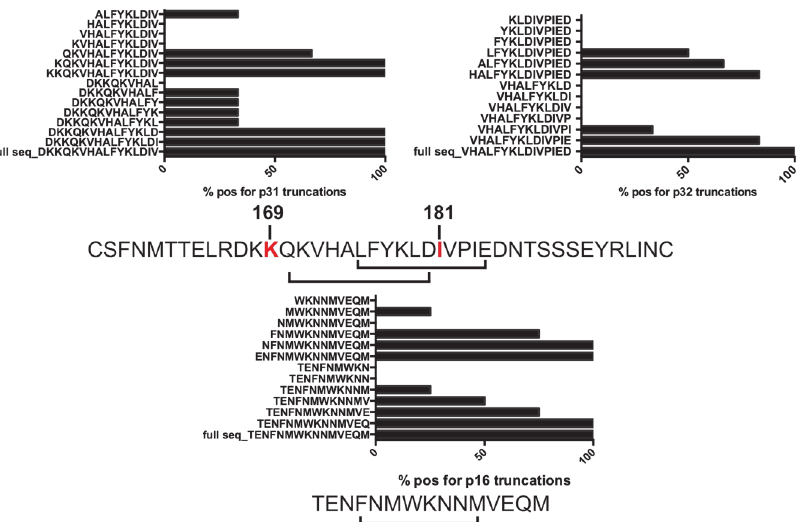
Figure 2. Env-specific CD4+ T cell lines that showed positive responses to either p16, p31 or p32, were tested in a modified ELISpot against a panel of truncated peptides based on the full sequence of p16 (gp120 C1 region), p31 and p32 (gp120 V2 region). Addition of Q (aa 170) increase % positive to about 60% and 100% response is reached when K (aa169) is added. Position 180 (D) is also critical as the number of responders increased from about 30% to 100%. This position is extremely conserved and forms the α 4 β 7- binding motif. Amino acid at position 176 (F) is important for antibody binding. HAL aa sequence is within a highly conserved region of the V2 loop. Sequences below the graph depict where the mapped epitope lies. The amino acids within boxes were sieve signatures described by Rolland et al. [12].